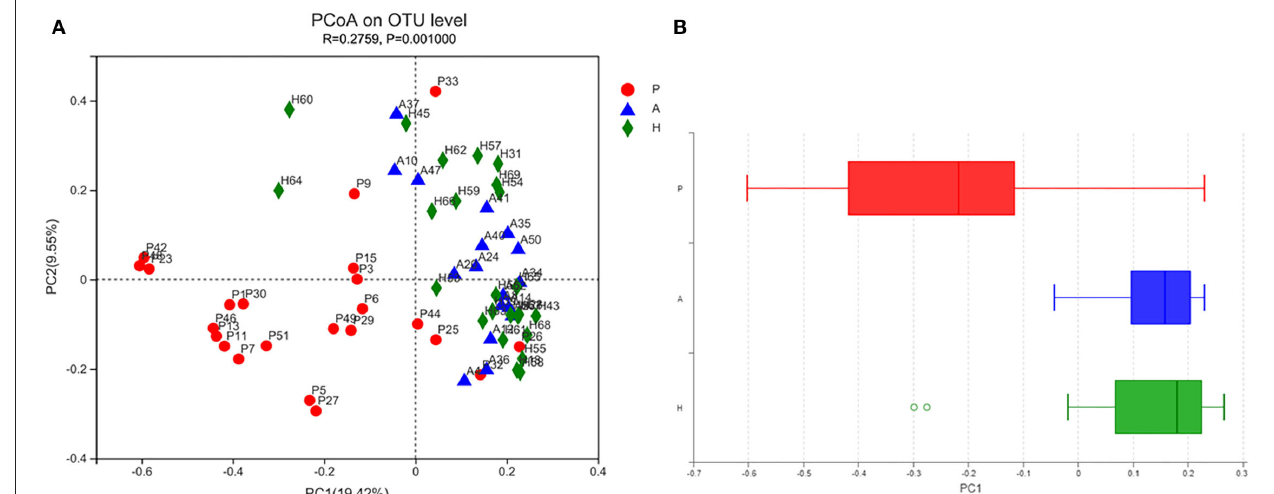
FIGURE 4 | Bacterial microbiota biodiversity. (A) Principal coordinates analysis (PCoA) of the microbiota among the Peutz–Jeghers syndrome (PJS), AR, and HC groups (group P, patients with PJS; group A, asymptomatic relatives; group H, healthy controls). (B) Box plots of beta diversity in patients with PJS (red), asymptomatic relatives (blue), and healthy controls